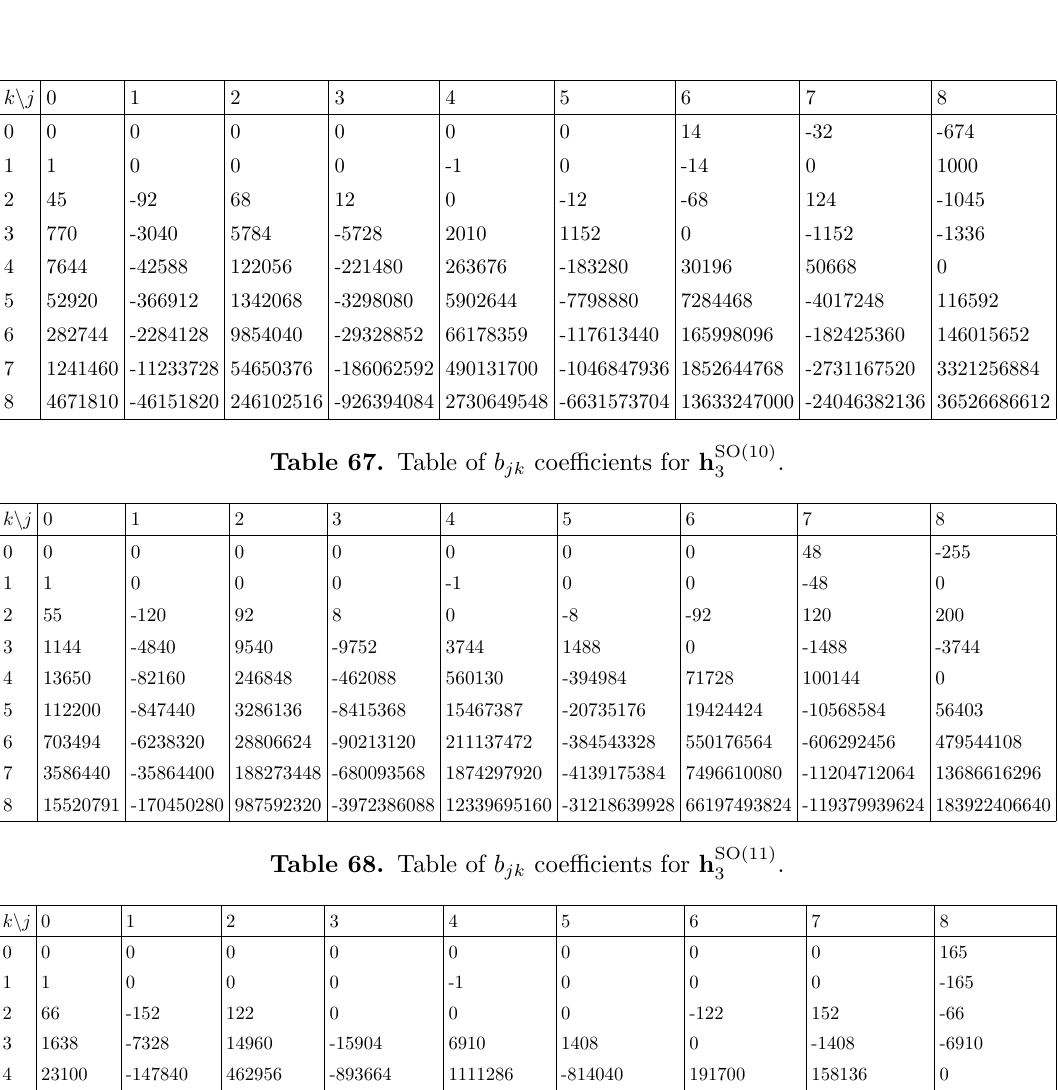
Table 69. Table of b jk coe(cid:14)cients for h SO(12)